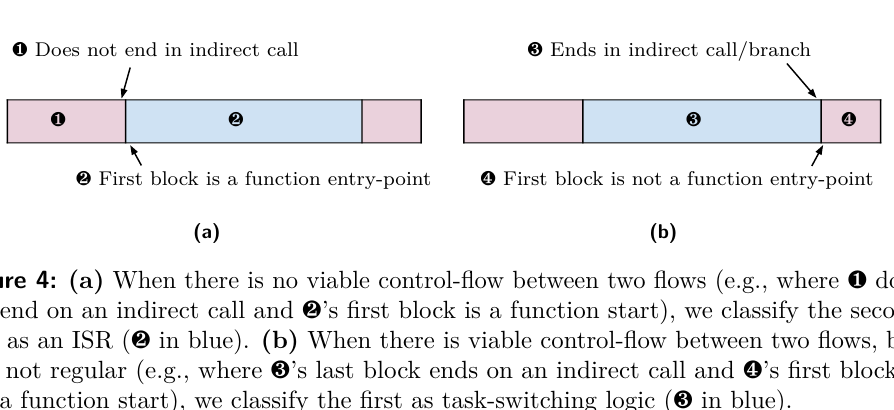
thus compute the length of the common prefix between two sequences as the minimum of the reported LCP length and the difference between their indices in the suffix